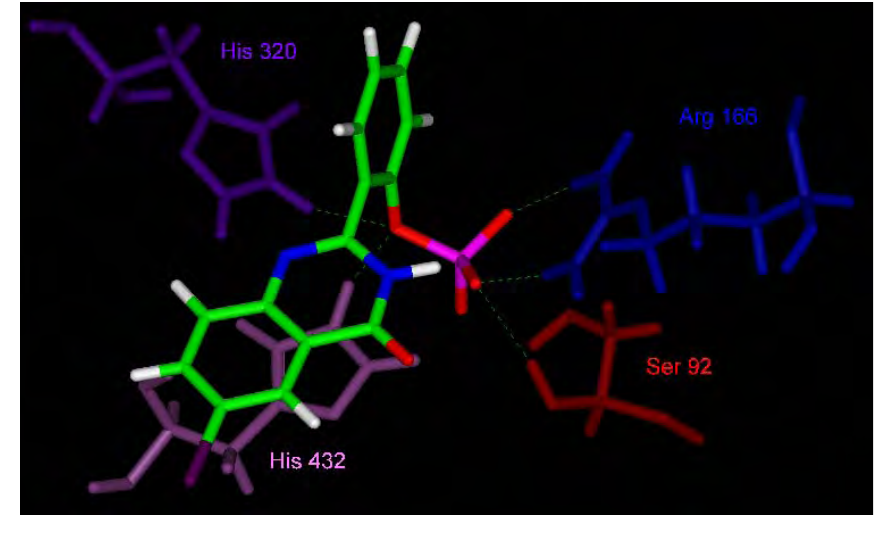
Figure 2. In silico docking positions of IQ